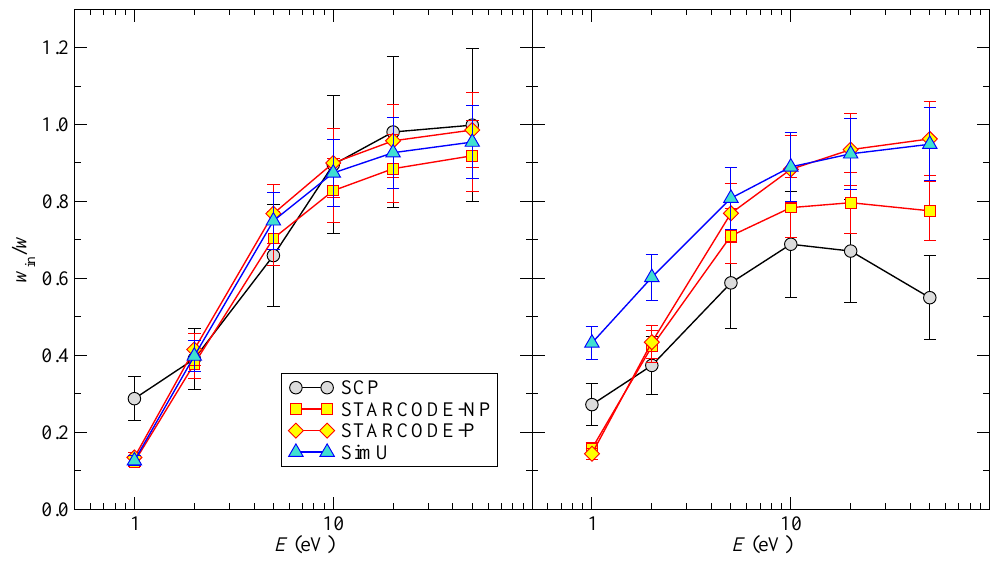
Figure 3. Li I 2 s − 2 p fractional inelastic width as a function of energy E . ( Left ) only the dipole interaction is taken into account; ( Right ) the dipole and quadrupole interactions are both taken into